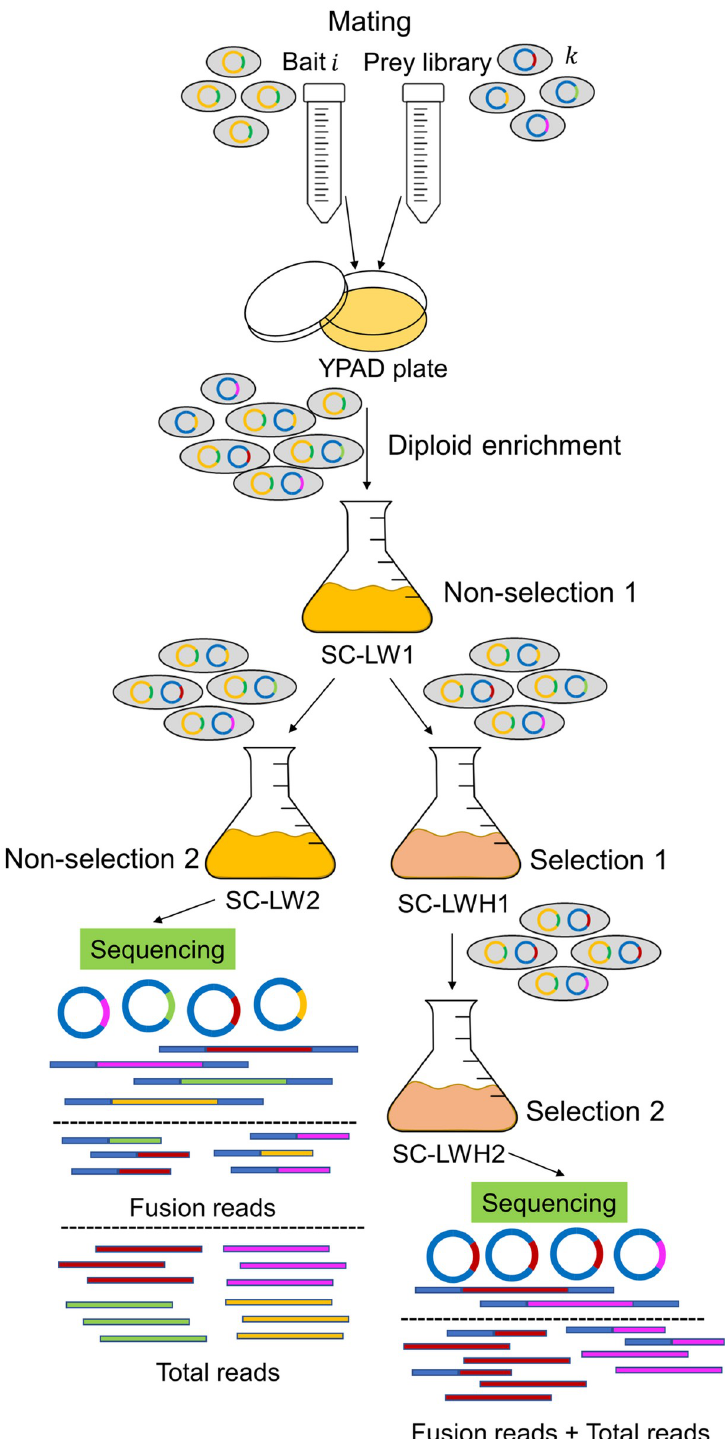
Fig 1. Y2H-NGIS workflow. Experimental workflow for batch Y2H-NGIS. After the mating between bait and prey, diploids go through a non-selective culture to reach exponential phase. Once there, the culture is split into two flasks, one for non-selection and another for selection. After reaching saturation in each condition, culture aliquots are taken to be sequenced.